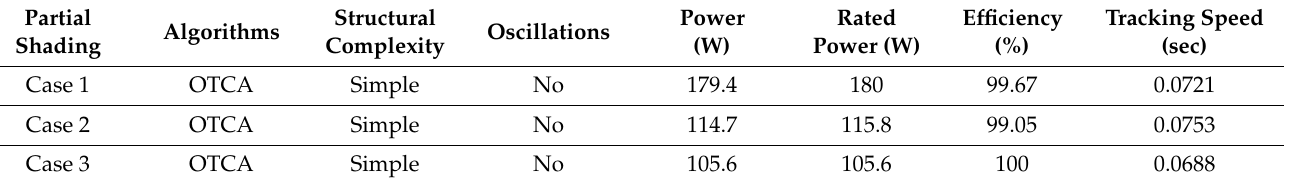
Table 9. Performance comparison of OTCA for 3S2P PV system for all test